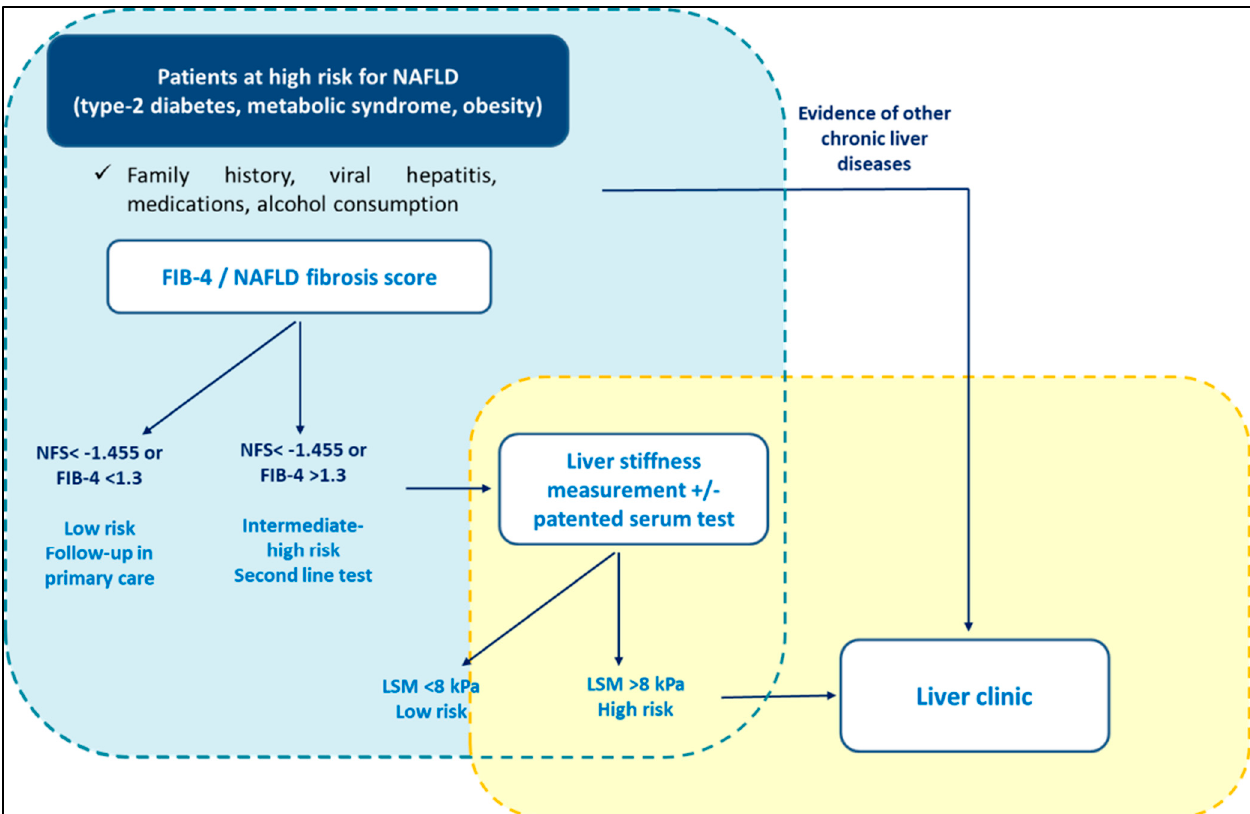
Figure 3. Screening for NAFLD in primary care. International guidelines recommend screening for NAFLD in high-risk populations (i.e., patients with metabolic syndrome) following a two-tier system.